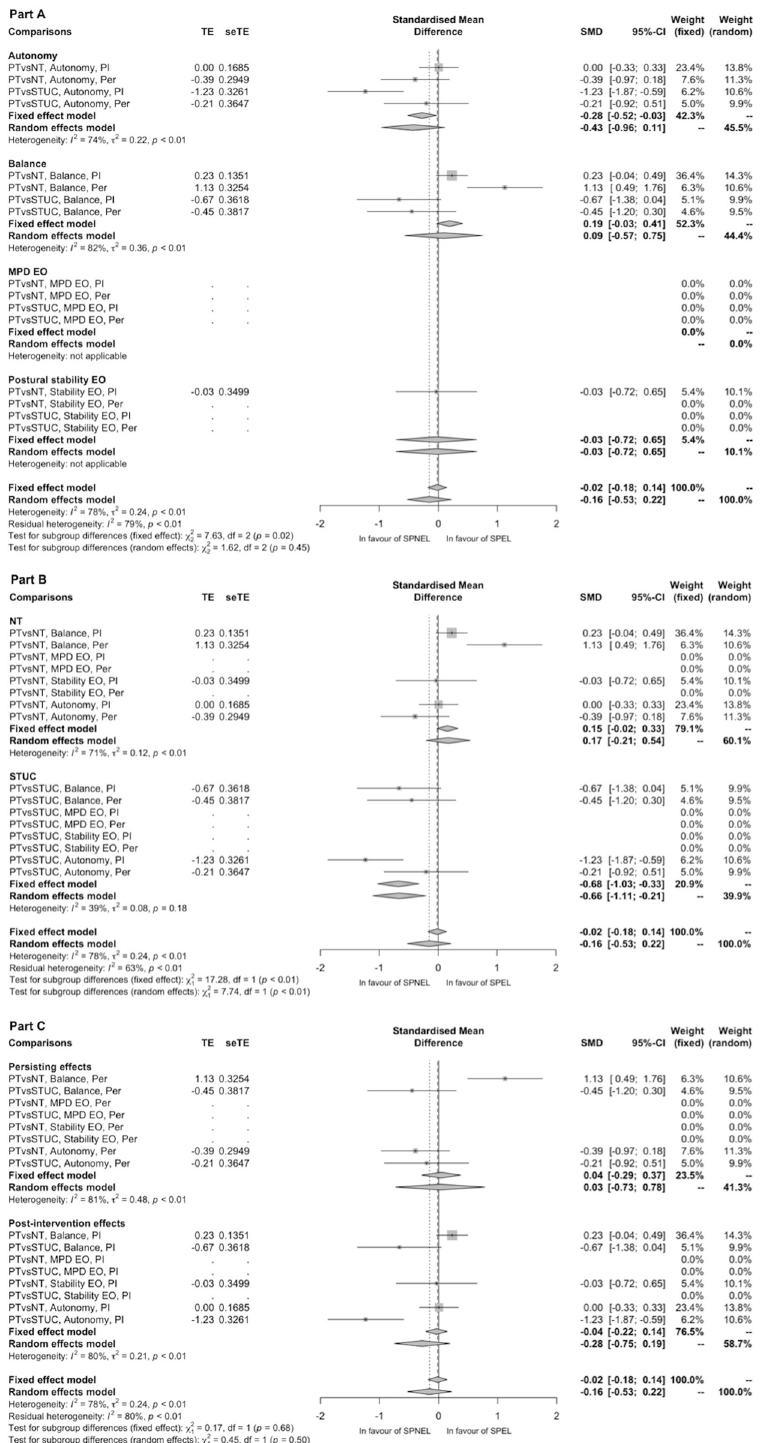
Fig 5. Forest-plot of estimates of treatment effects from studies published in non-English language compared to those published in English language for analyses of all outcomes. EO, eyes opened; Imm, immediate; MPD, mediolateral postural deviation; NT, no treatment; Per, persisting; PT, physical therapy; seTE, standard error of treatment effect; SMD, standardised mean difference; SPEL, studies published in English language; SPNEL, studies published in non-English language; STUC, sham treatment and usual care; TE, treatment effect; vs, versus.